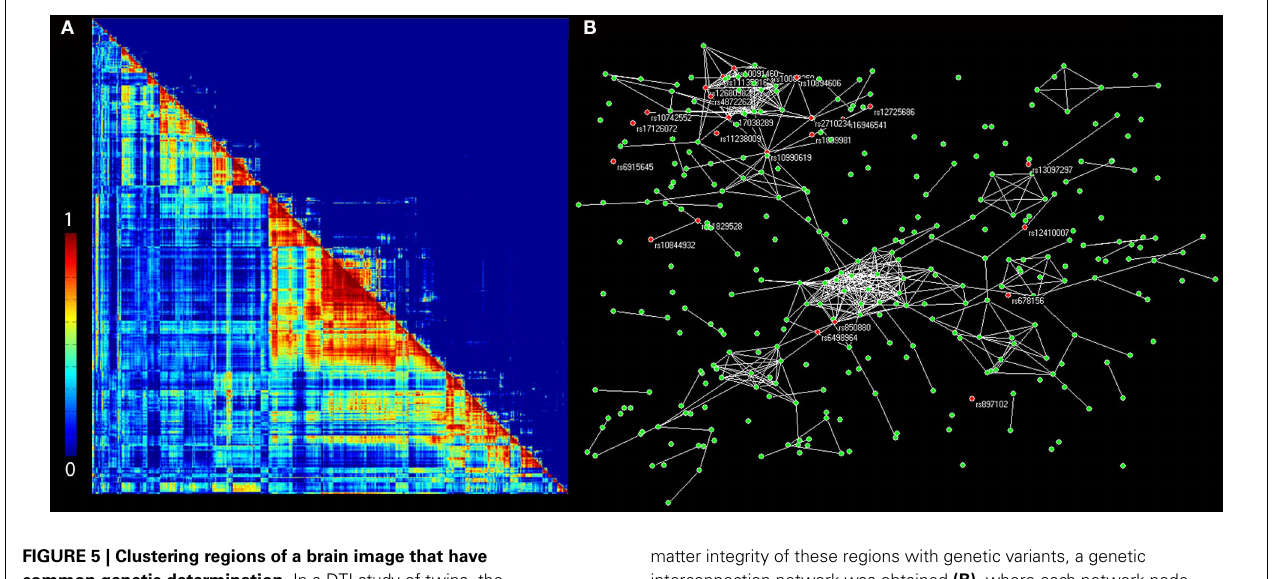
FIGURE 5 | Clustering regions of a brain image that have common genetic determination. In a DTI study of twins, the known kinship structure made it possible to estimate the genetic correlation matrix and a “topological overlap (TO)” index matrix. This was used to gage the similarity of genetic influences on all pairs of brain regions (A) .The 18 largest clusters – parts of the image with common genetic influences – were selected as regions of interest (ROIs) for GWAS. By associating the mean white